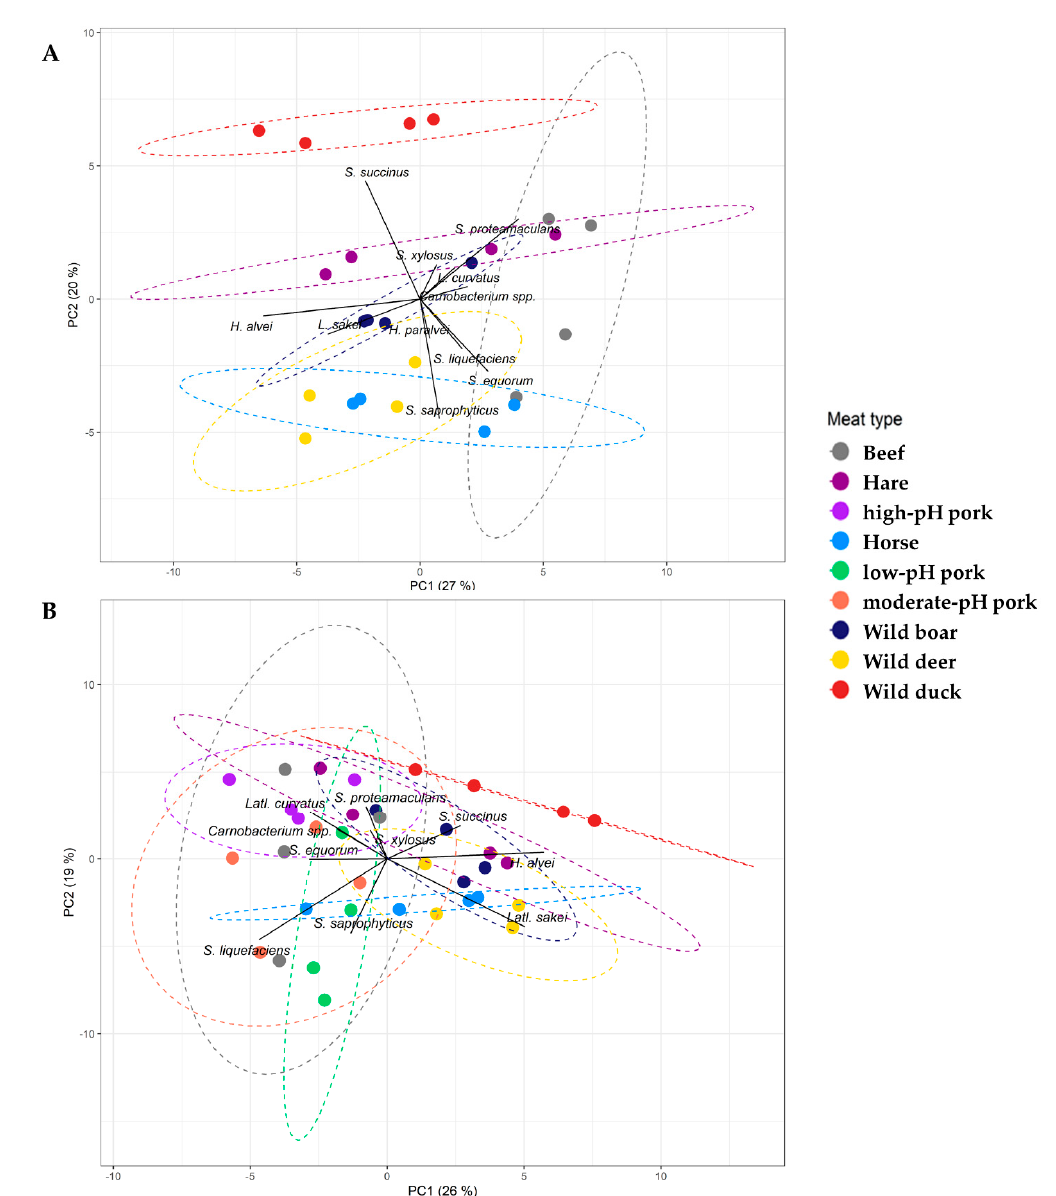
Figure 4. Centred principal component analysis (PCA) biplot based on Bray–Curtis dissimilarity scores of the bacterial community structures obtained during fermentation of less conventional meat types ( A ) and extended with the fermented pork samples to the entire dataset ( B ), with factor loadings. Only factor loadings with an absolute value above 1 were considered. Colours indicate different sample groups, beef (gray), hare (dark purple), high-pH pork (light purple), horse (light blue), low-pH pork (green), moderate-pH pork (orange), wild boar (dark blue), wild deer (yellow), and wild duck (red). The proportion of variance for every PC is indicated between brackets. The dotted lines represent 90% normal confidence ellipses for the sample groups.